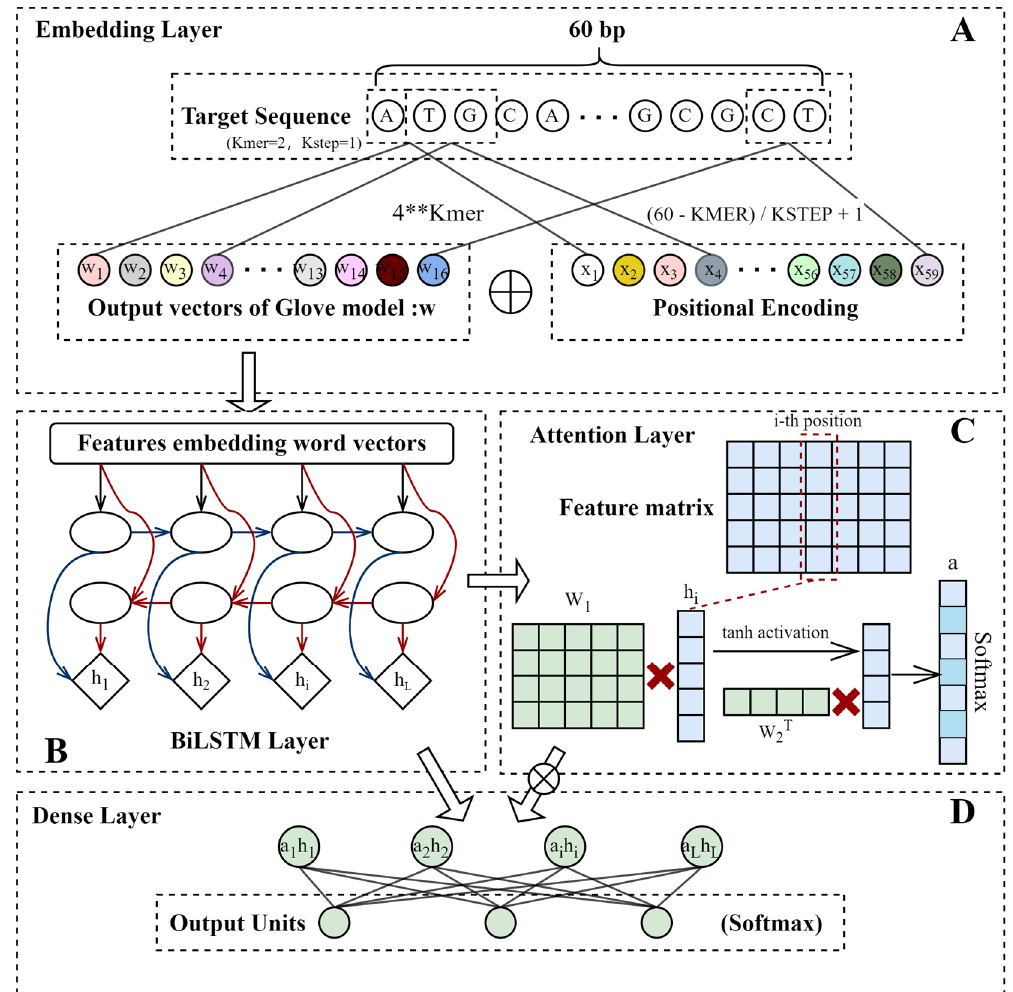
Figure 2. Apindel architecture. ( A ) Embedding layer, mainly consisting of GloVe model and Positional Encoding. ( B ) BiLSTM layer, used to capture the contextual information in the input message. ( C ) Attention layer. The feature matrix output from the previous layer calculated the attention vector, which stored the importance scores of different loci of the sequences on the final prediction outcomes. ( D ) Dense layer. The attention vector was combined with the BiLSTM layer output, and the final, fully connected layer was used to obtain the final results.